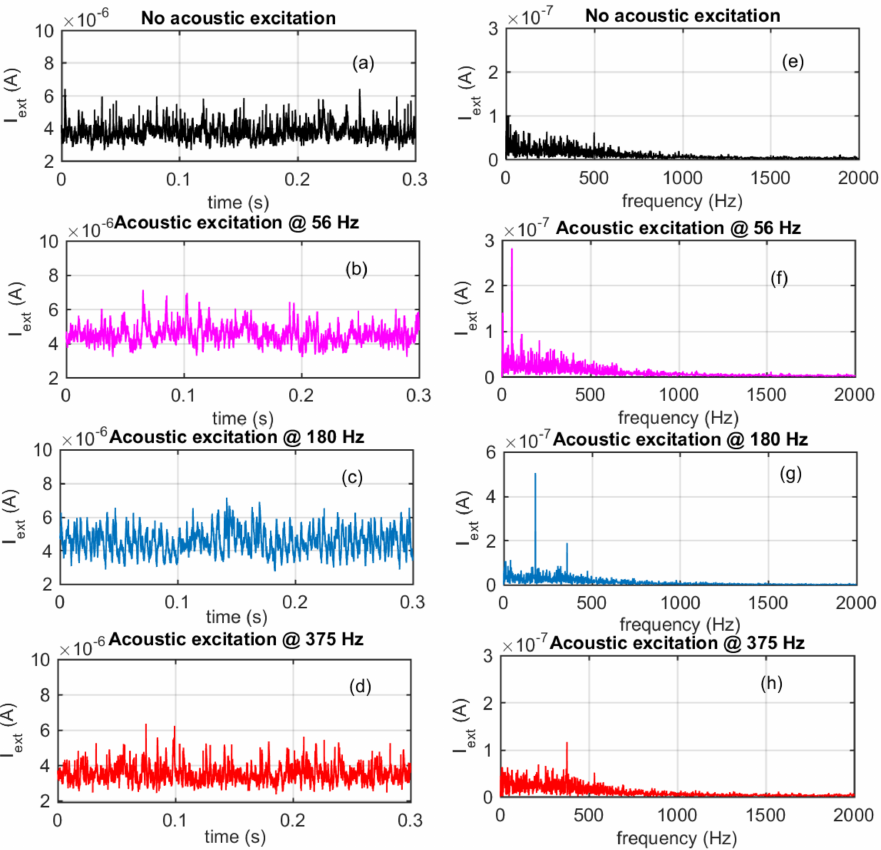
Figure 11. Signals from the spark plug front end circuit in the absence and in the presence of acoustic excitation as a function of time ( a – d ), and FFT of the acquired signals ( e – h